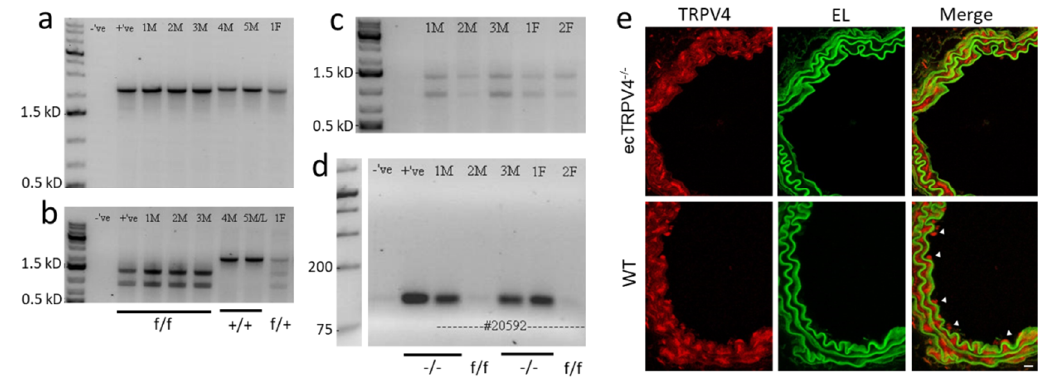
Figure 1. Endothelium-specific TRPV4 knockout mouse genotyping and arterial expression. ( a ) DNA